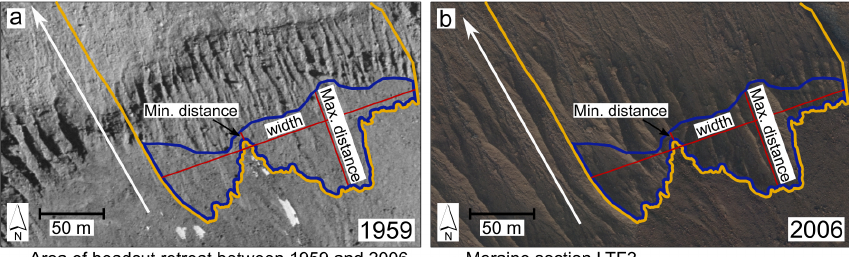
Figure 3. Measuring of the headcut retreat for the example of moraine section LTF2: (a) orthophoto of 1959 and (b) orthophoto of 2006 (aerial images of 1959 are from IGMI, and the 2006 orthophoto was provided by the Autonomous Province of Bolzano-South